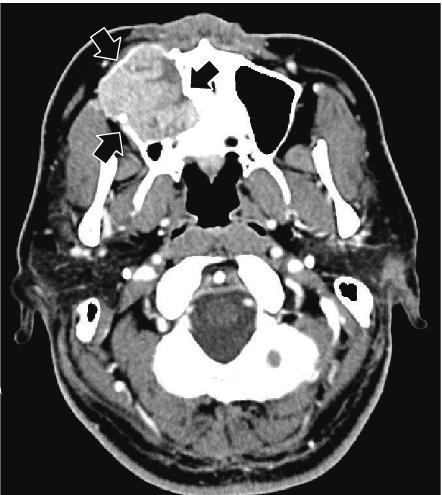
Figure 3: An axial CT image shows a soft tissue density mass eroding the anterior and lateral walls of right maxillary sinus